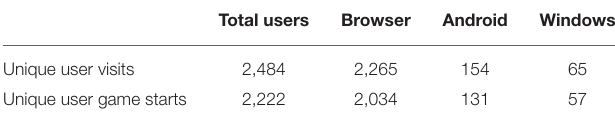
TABLE 1 | Unique players sorted by